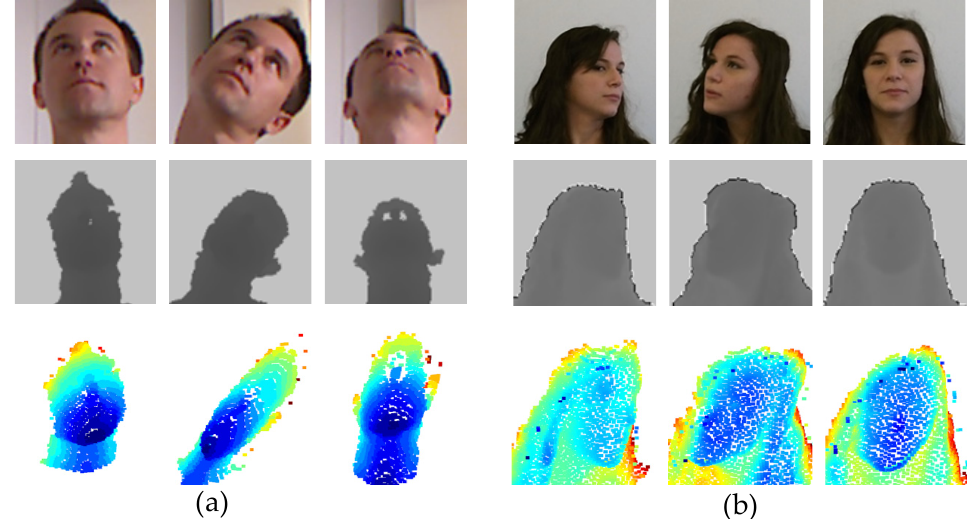
Figure 5. Examples of Biwi Kinect Head Pose dataset ( a ) and Pandora dataset ( b ). The first line is the RGB images, and the second and third lines are the corresponding depth maps and point clouds, respectively.